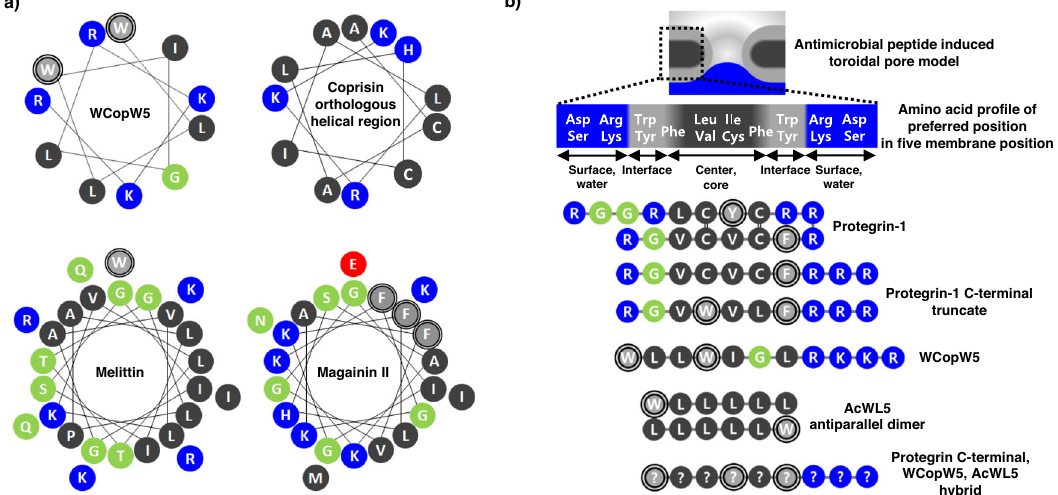
Fig. 1 Predicted amphipathy of antimicrobial peptides. a Secondary amphipathic α -helical model and b primary amphipathic β -strand model of AMPs. For simplicity, the membrane is shown as a simple electrostatic fi ve-slab model. For easier viewing, the exact thickness of the membrane and chirality of the D-form amino acids are omitted and shown in supplementary fi gures 30,35 (Supplementary Figs. 1 and 2). WCopW5 is more similar to the primary amphipathic β -strand model of